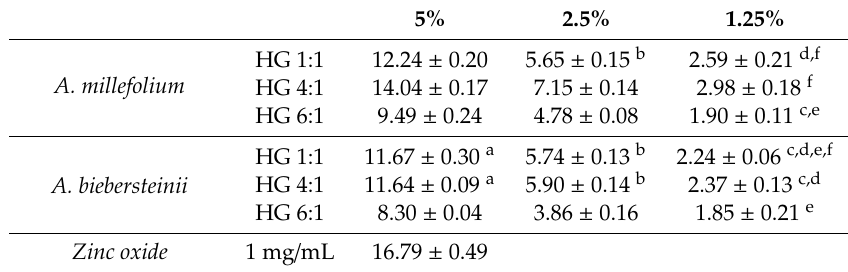
Table 5. In vitro sun protection factor (SPF) of hydroglycolic (HG) extracts from A. millefolium and A. biebersteinii , each value represents mean ± SD ( n = 3